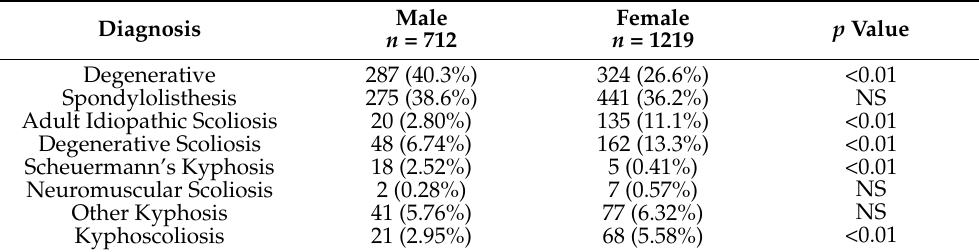
Table 2. Comparison of patient diagnosis by gender.